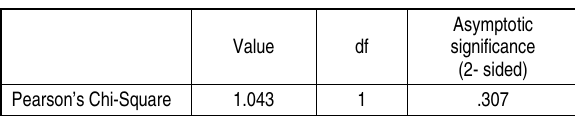
Table 3. Chi-Square Test – gender and awareness of